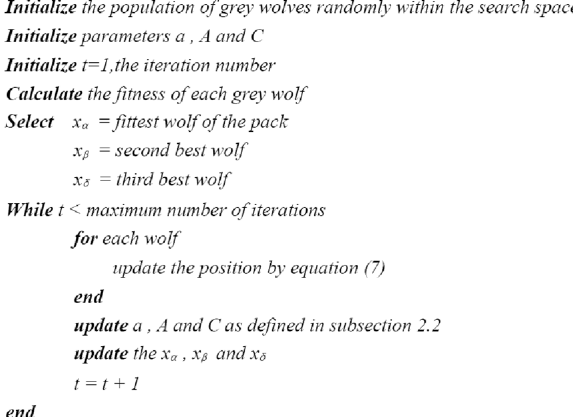
Figure 2. The pseudo code of the traditional GWO